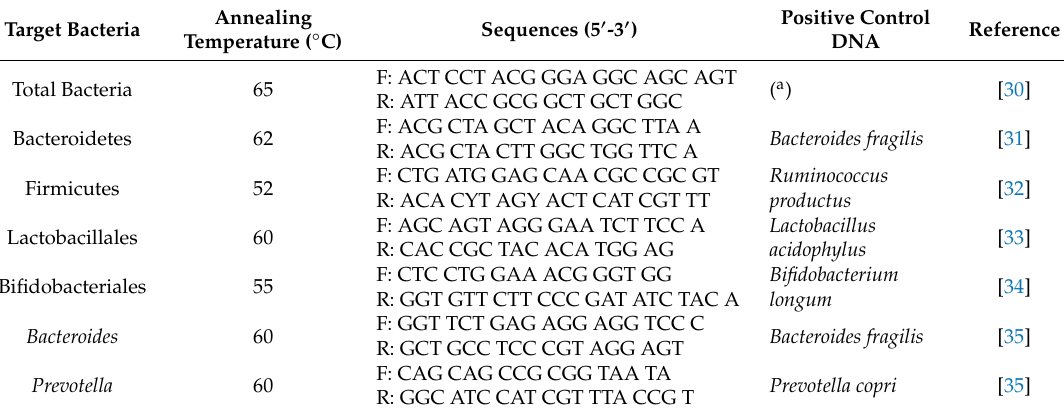
Table 1. Quantitative real-time polymerase chain reaction (PCR) primers and conditions. Target